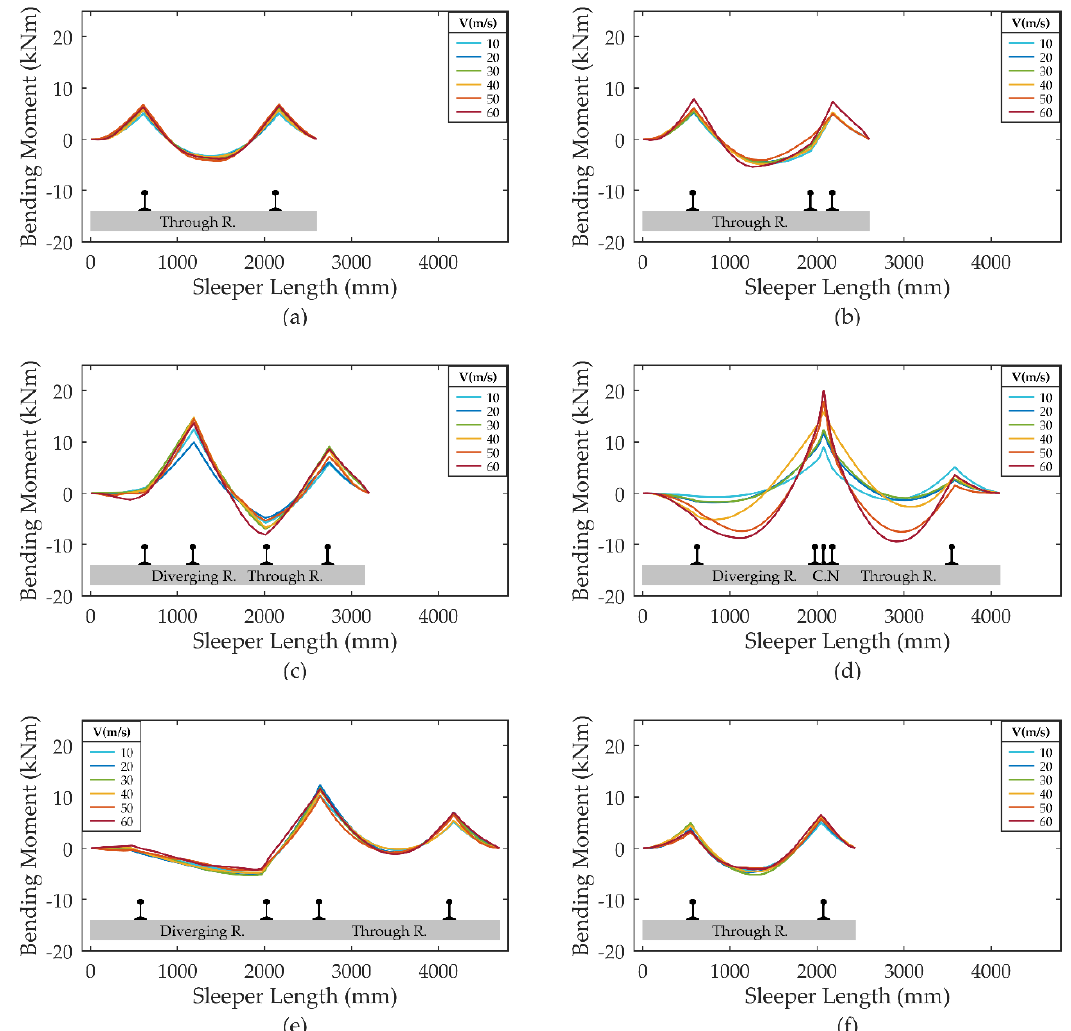
Figure 8. Flexural responses of sleepers and bearers: ( a ) Sleeper at the entrance; ( b ) sleeper under the switch blade; ( c ) sleeper at the closure panel; ( d ) sleeper under the crossing nose; ( e ) the longest sleeper; ( f ) the shortest sleeper.